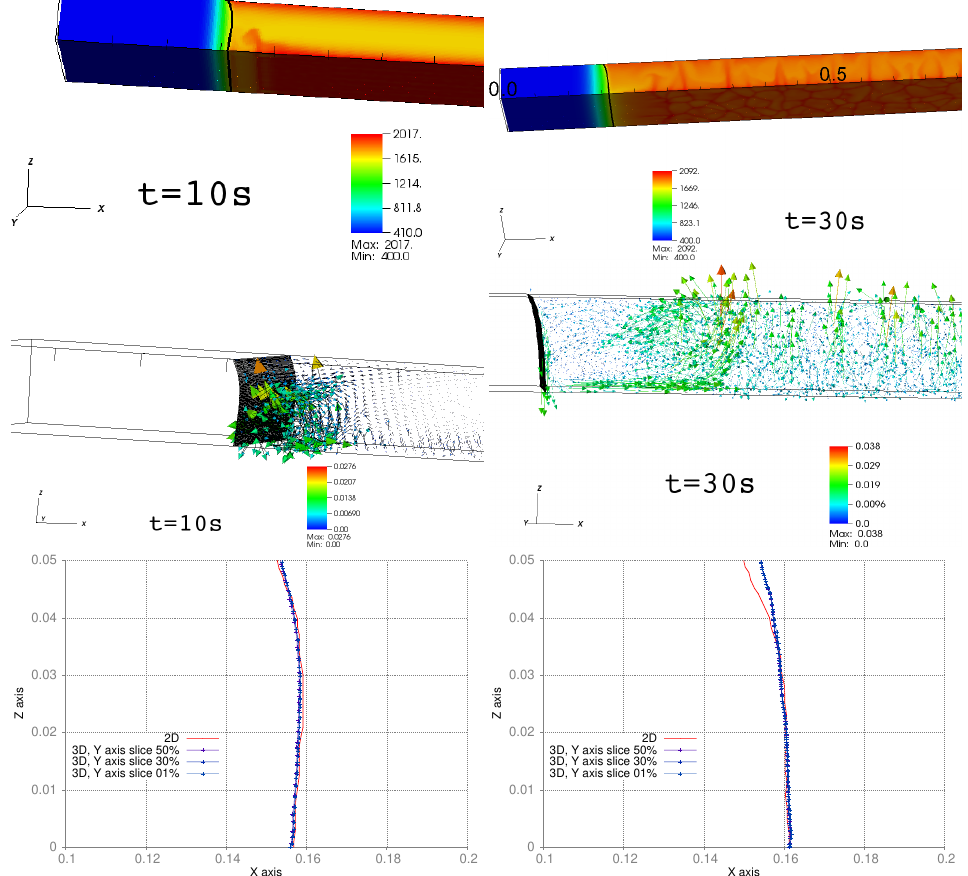
Figure 13. Three-dimensional visualization of the thin metal layer at an intermediate time (10 s and 30 s)—( Top ): temperature field in colors and black line for the interface. ( Middle ): velocity vectors in colors and fusion front in black line. ( Bottom ): position of the interface for different slices orthogonal to the y axis and comparison with the interface computed in the 2D test